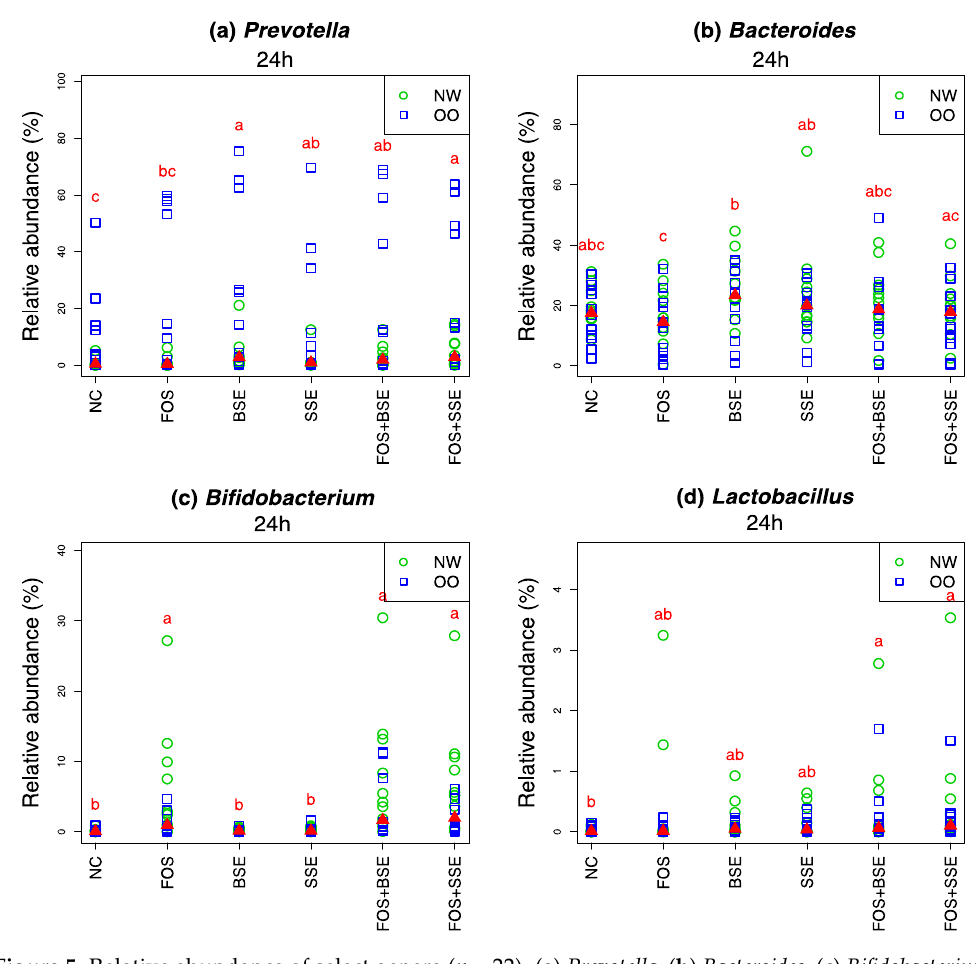
Figure 5. Relative abundance of select genera ( n = 22). ( a ) Prevotella , ( b ) Bacteroides , ( c ) Bifidobacterium , ( d ) Lactobacillus . Letters indicate significant differences between treatments at 24 h, achieved by the Friedman test and its post hoc multiple comparisons at 0.05 level of significance. The medians are marked with red triangles. The weight classes (NW vs. OO) are labeled by green circles and blue squares, respectively. NC: negative control, FOS: fructooligosaccharides, BSE: black sorghum bran extract, SSE: sumac sorghum bran extract.